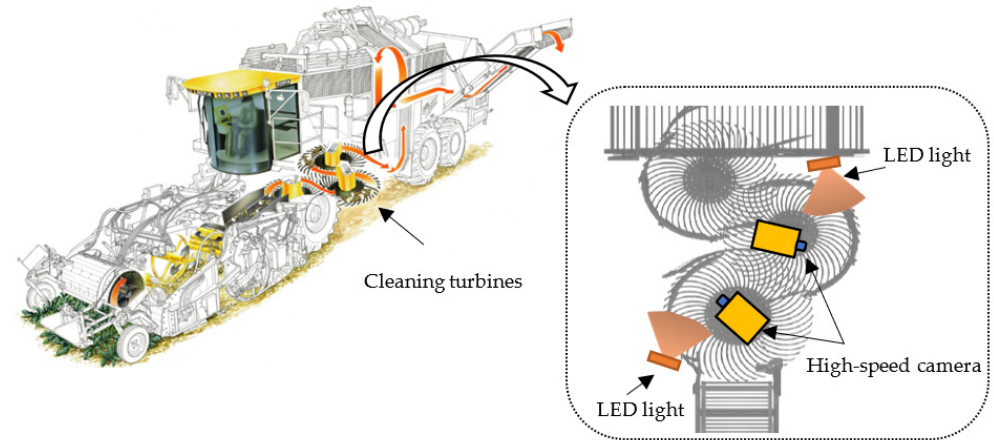
Figure 1. Schematic representation of the sugar beet harvester https://www.ropa-maschinenbau.de/site/assets/files/5615/ropa_euro-tiger_v8-4_d.pdf (accessed on 7 November 2021), attachment of cameras and LED lights during field trials.